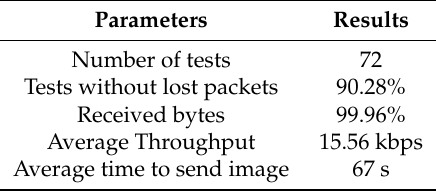
Table 9. Analysis of results obtained in scenario